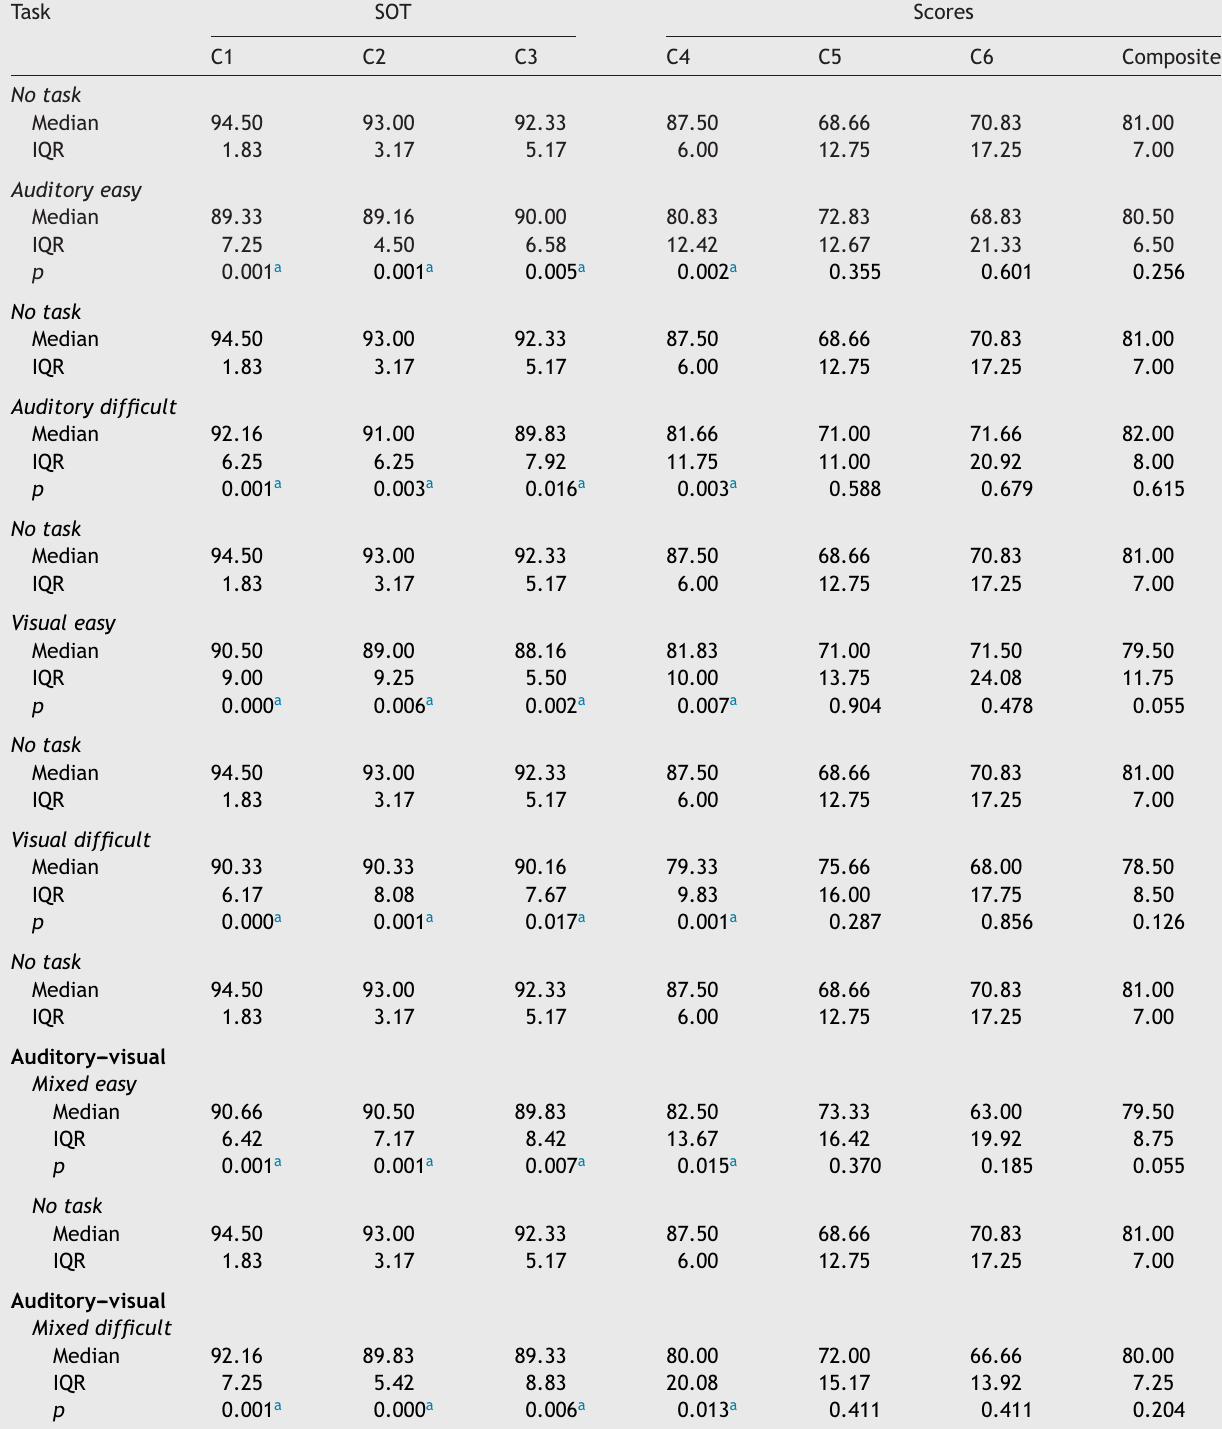
The comparison of the no-task SOT scores and SOT scores obtained simultaneously with cognitive